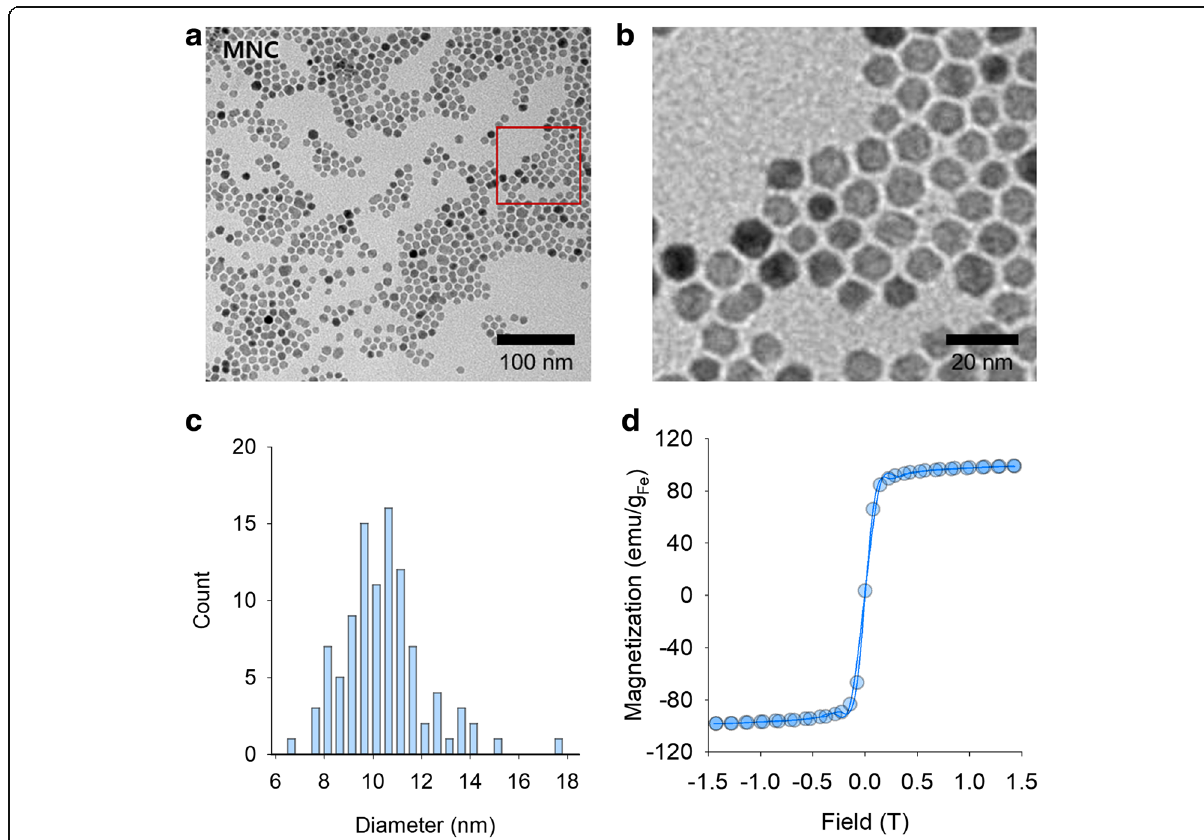
Fig. 2 The result of morphological and magnetic characterization of MNCs. a TEM image. b Magnified TEM image. c Size distribution measuring from TEM image (total count 100). d Magnetization graph